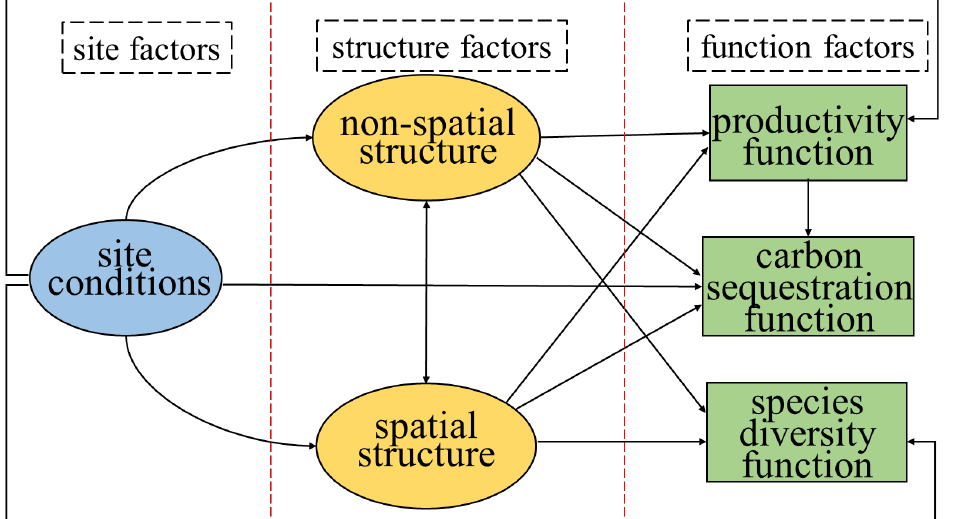
Figure 7. The a priori model based on the hypothesis relating stand structures, site conditions and stand functions. Structure factors include non-spatial structure and spatial structure; function factors include productivity, carbon sequestration and species diversity functions.